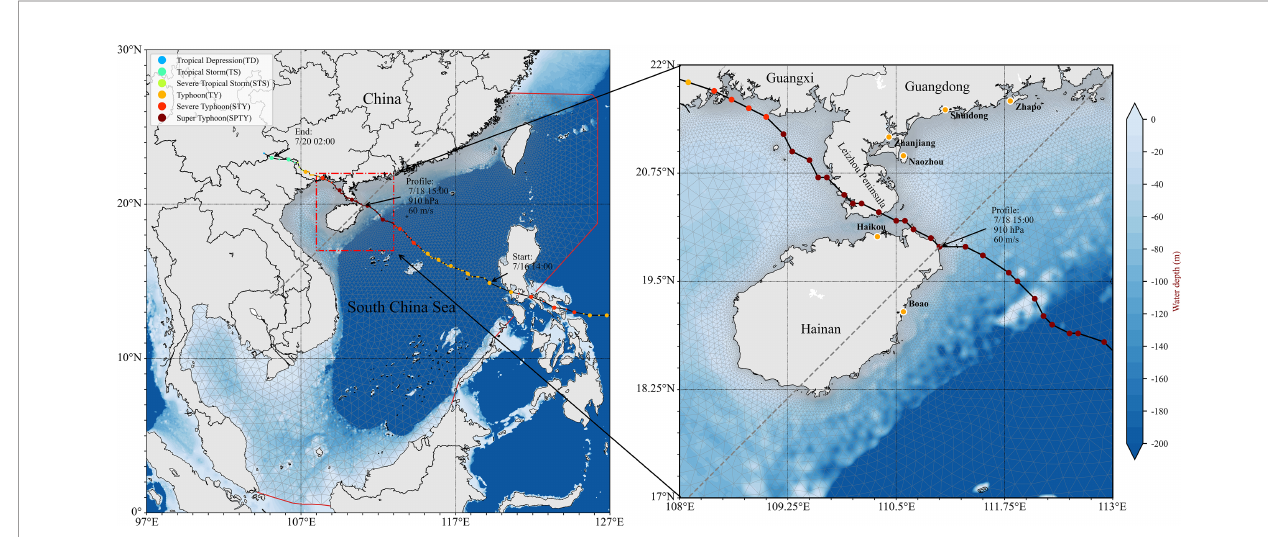
FIGURE 1 | Bathymetry of the South China Sea and model grid (left). Black line with colored dots represents track and intensity of Typhoon Rammasun (2014). Enlarged view of the vicinity of Hainan province (Right). Yellow dots show location of six tide gauge stations (Zhapo, Shuidong, Zhanjiang, Naozhou, Haikou, and Boao